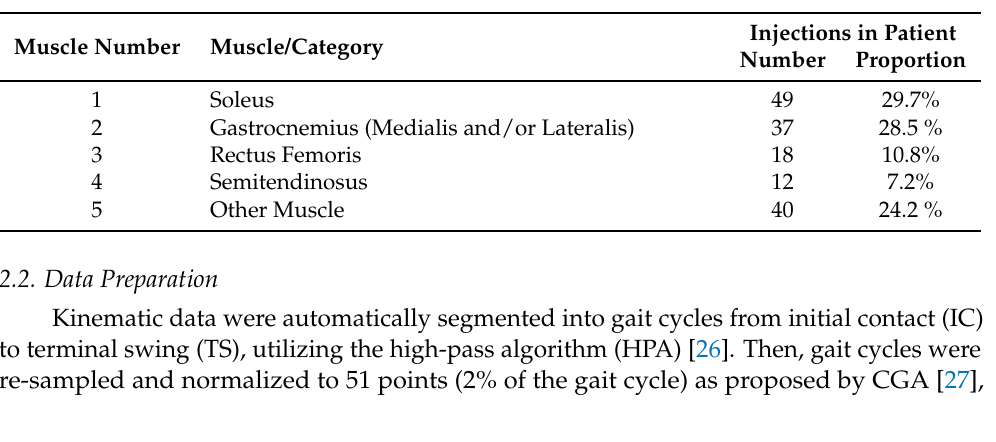
Table 2. Considered injected muscles and their frequencies in the